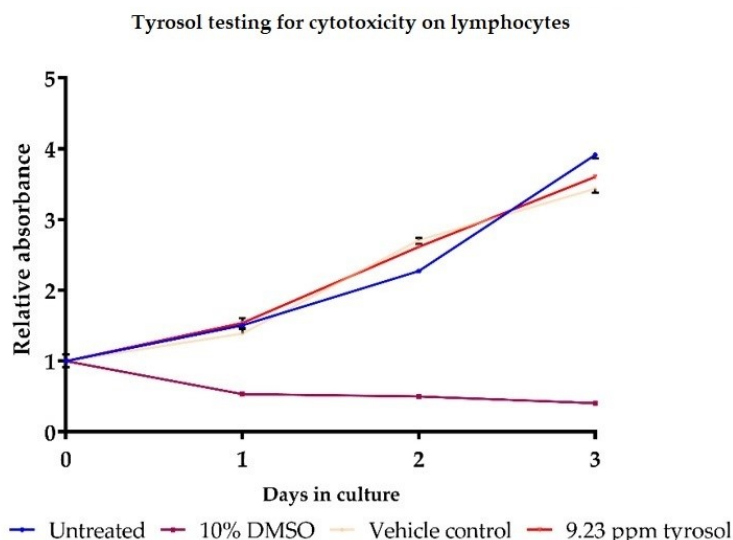
Figure 3. Cytotoxicity curves of activated lymphocytes at 0, 1, 2, and 3 days following tyrosol expo- sure using MTT assay. Untreated = Negative (medium) control for cytotoxicity; 10% DMSO = Positive control for cytotoxicity; Vehicle control = 0.5% Ethanol. Each value is a median value where n = 9 ( n = 3 for 3 separate experiments). Values normalised to initial cell number.Error bars represent differences between the median and upper and lower quartiles.